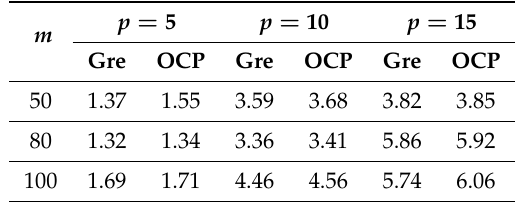
Table 4. Optimal Chernoff Distances of Two